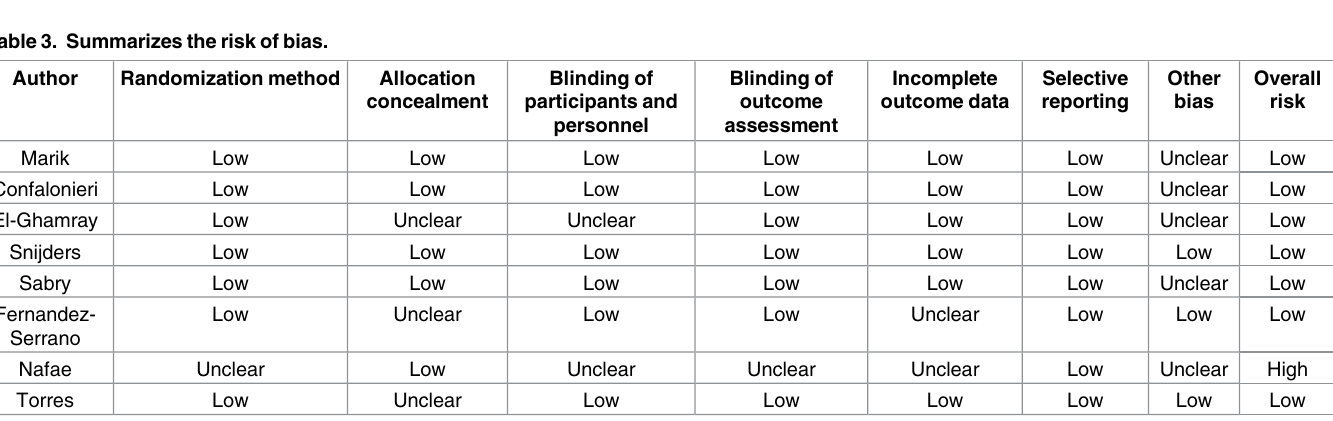
Table 3. Summarizesthe risk of